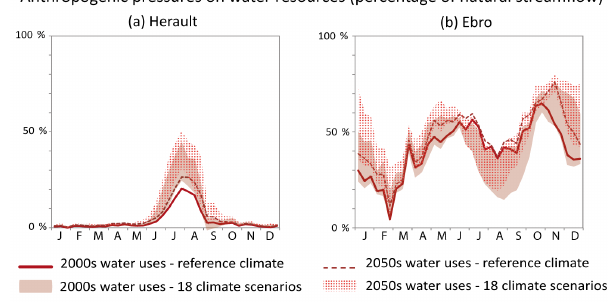
Figure 6. Anthropogenic pressures on water resources under four combinations of climate and water use scenarios in (a) the Herault basin and (b) the Ebro basin. Anthropogenic pressure is computed through the difference between natural and influenced streamflow at the outlet of each basin, expressed as a percentage of natural stream-